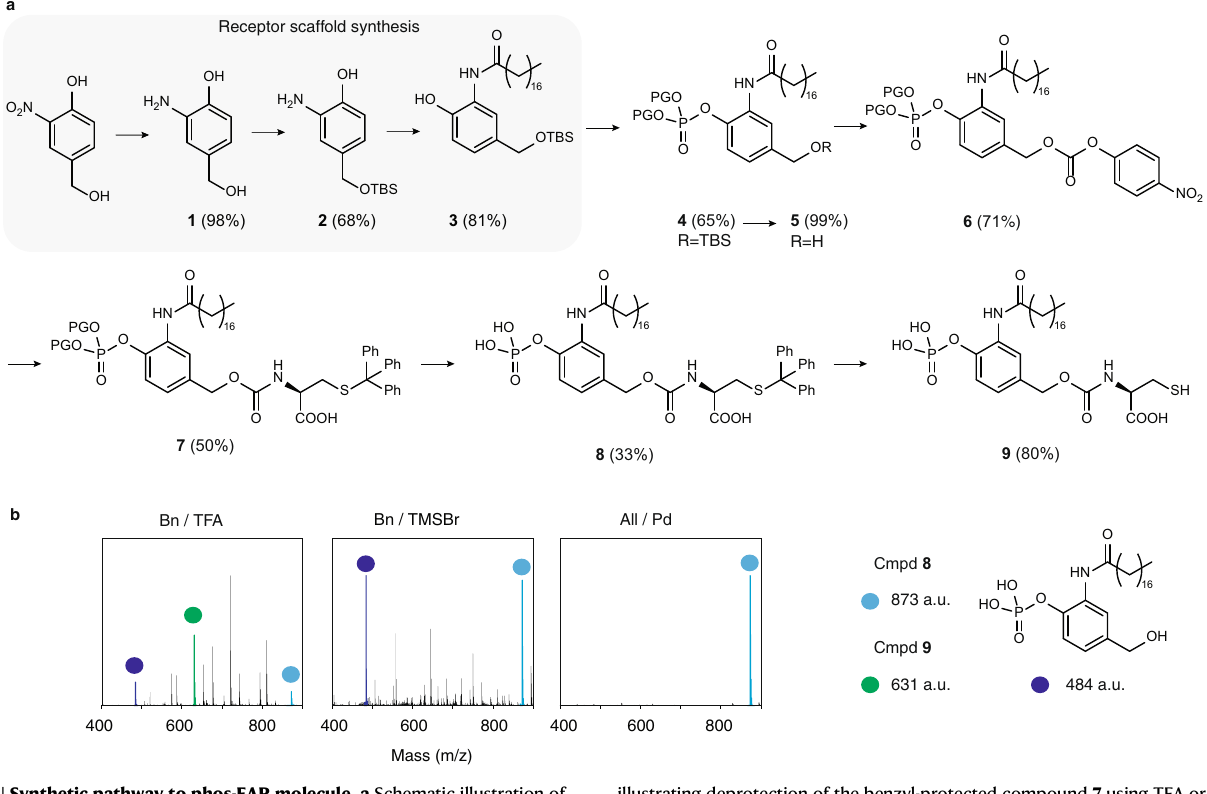
illustrating deprotection of the benzyl-protected compound 7 using TFA or tri- methylsilyl bromide (TMSBr), and an allyl-protected 7 through Pd-catalyzed deal- lylation. For detailed reaction conditions, see Supplemental